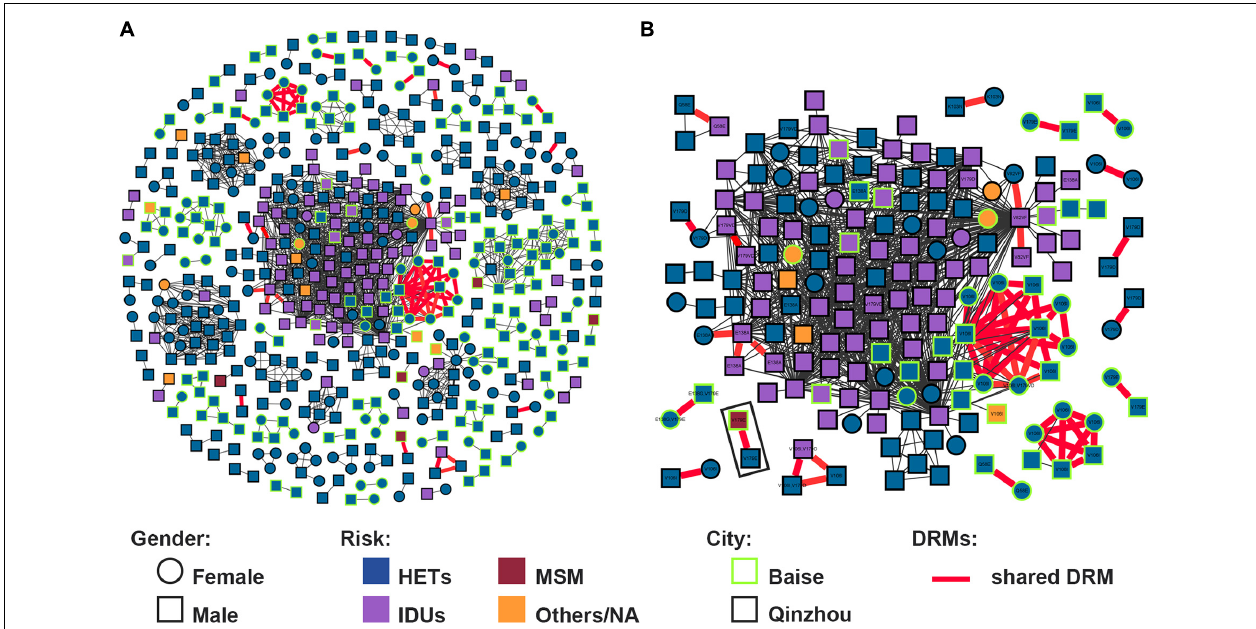
FIGURE 2 | HIV-1 transmission clusters (TCs) of PDR in two severe drug abuse regions in Guangxi, 2015–2019. (A) All clusters are shown. (B) Enlargement of clustering individuals harboring shared DRM labeled with each node. Squares and circles denote male and female. Nodes color indicates the reported transmission route and the frame color indicates the sampling city. All edges represent a genetic distance (GD) of < 1.5%. Edges in bold red indicate individuals who shared DRM.